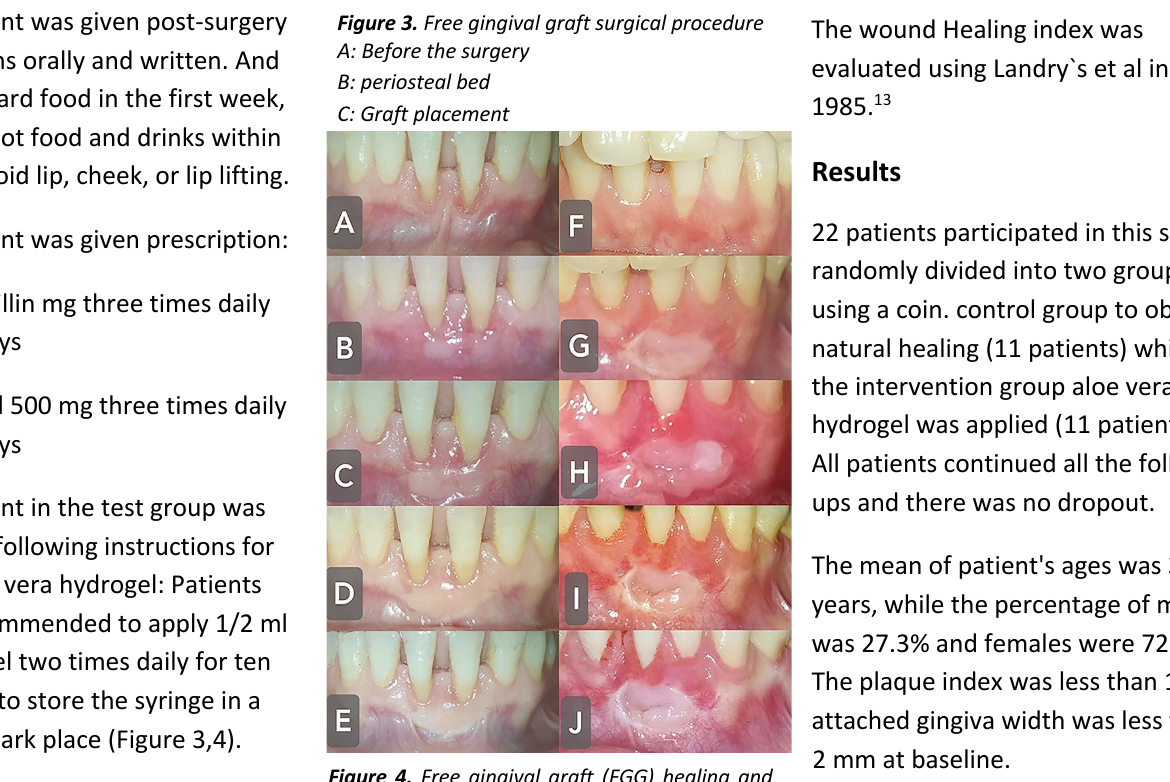
Figure 4. Free gingival graft (FGG) healing and